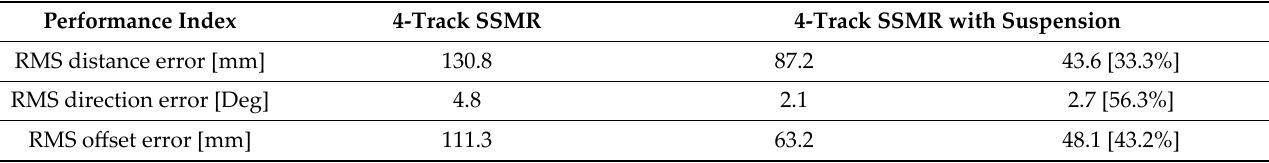
Table 5. Maneuverability performance